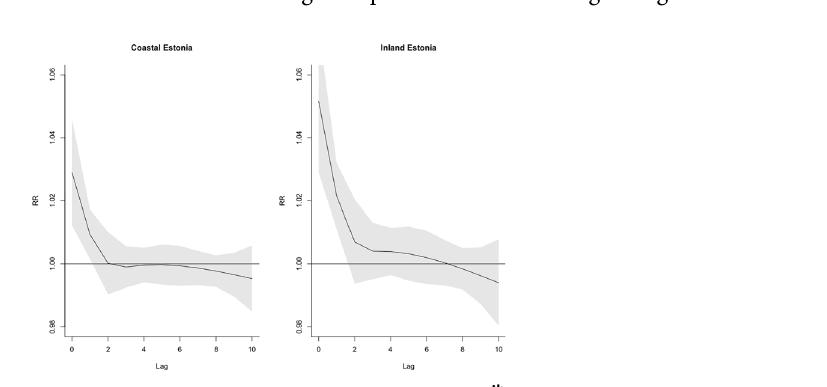
Fig 2. The estimated RR of total mortality at the 90 th percentile of daily maximum temperature for lags 0 – 10 for the coastal and inland region of